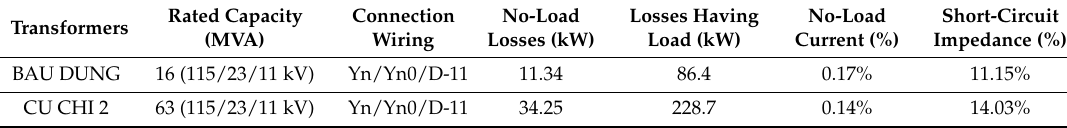
Table 7. Transformer parameters of a real 22 kV distribution